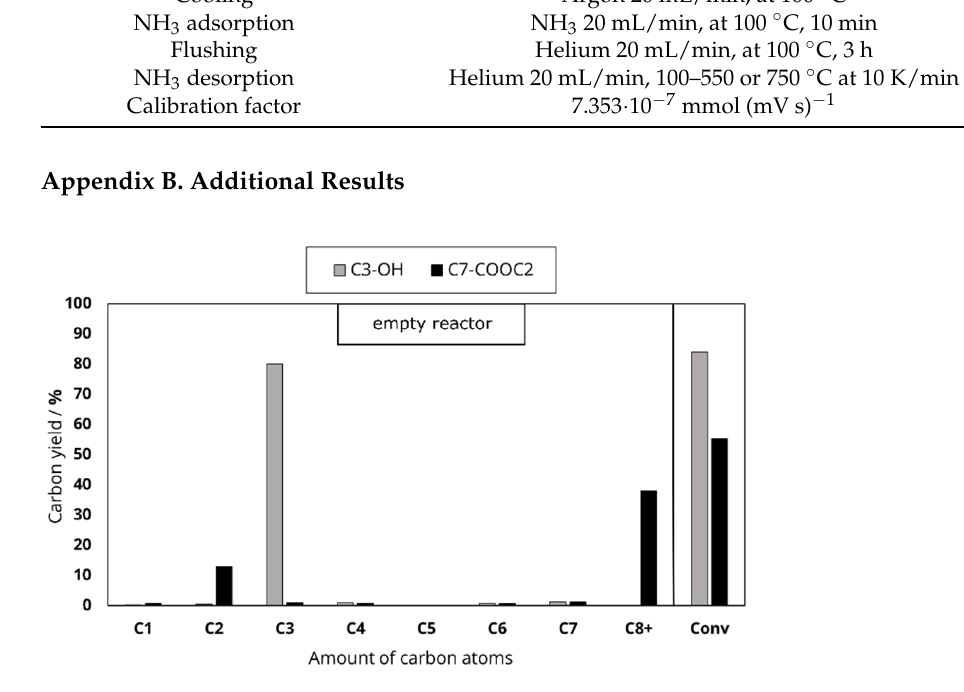
Figure A1. Comparison of empty reactor test results after 0.5 h ToS for the conversion of n-propanol (C3-OH) and ethyloctanoate (C7-COOC2); grey bars: almost exclusive formation of propene (C3) from dehydration of C3-OH at 83% conversion; black bars: almost exclusive formation of octanoic acid and ethylene at 55% conversion.